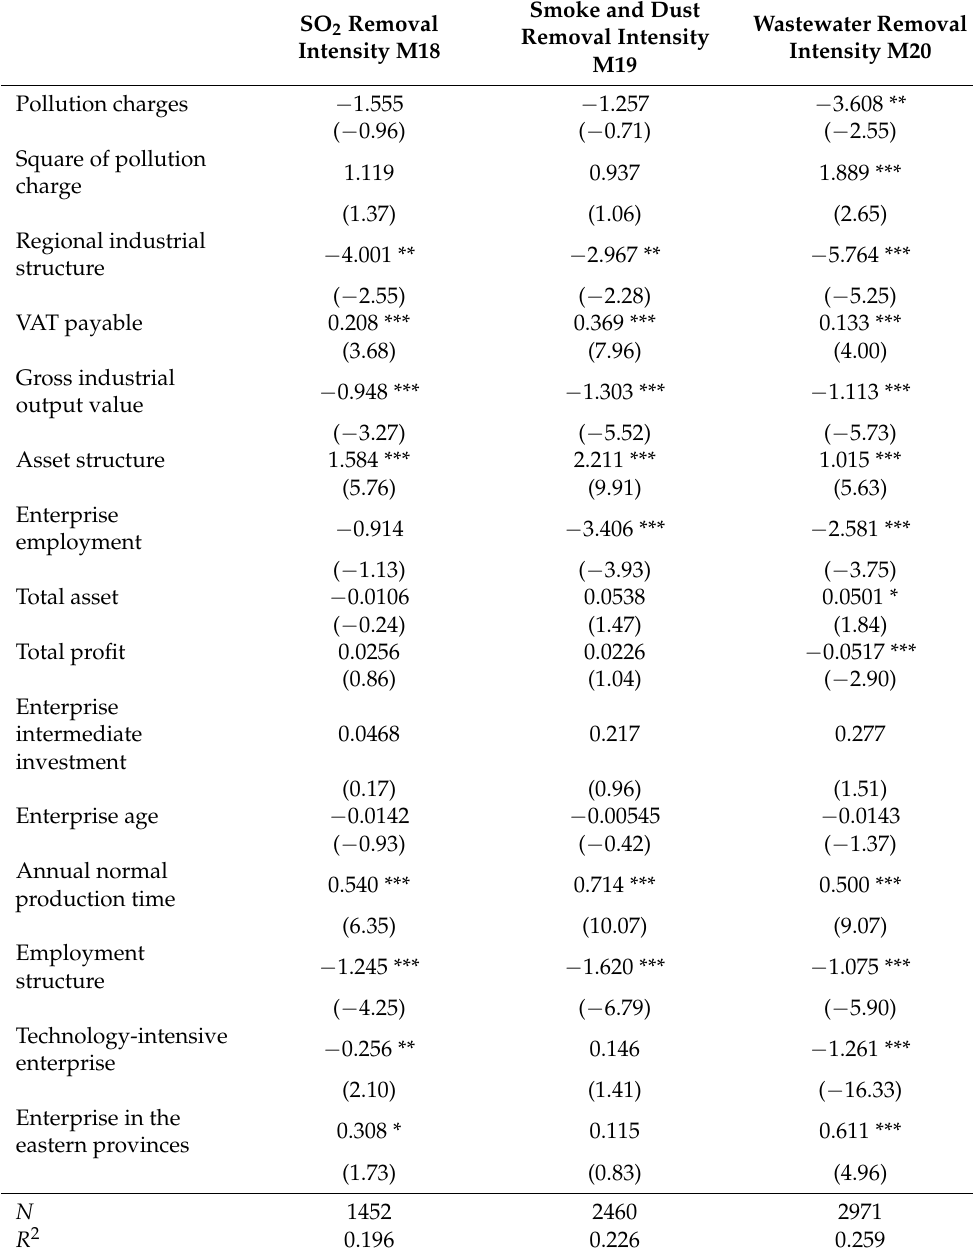
Table 7. Regression results of the impact of pollution charges on enterprises’ end-treatment techno- logical innovation in